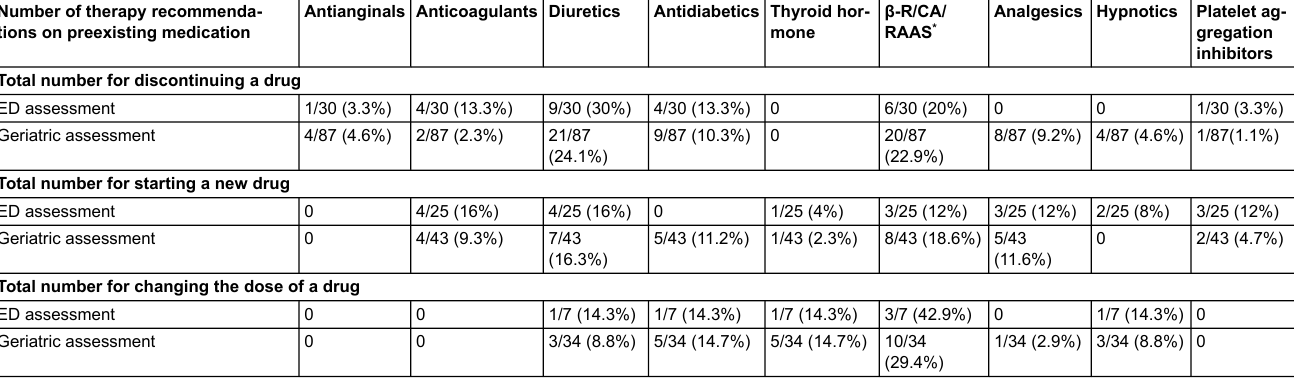
Table 2: Distribution of the most common drug groups in the preexisting medication (at least three therapy changes in one of the interventions) for which a therapy change was recommended after geriatric and emergency department (ED) assessment. Number of therapy recommenda- Antianginals Anticoagulants Diuretics Antidiabetics Thyroid hor- tions on preexisting medication